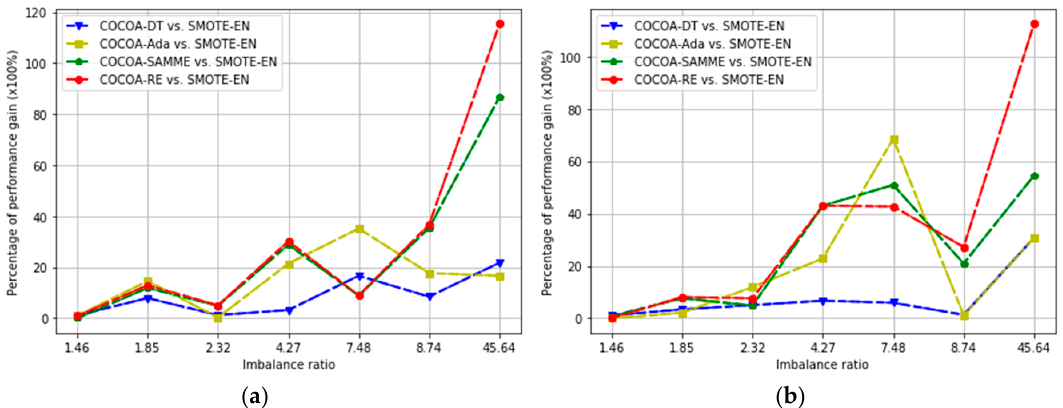
Figure 2. Percentage of performance gain between each algorithm based Cross-Coupling Aggregation (COCOA) and SMOTE-EN ( PG q ) changes along imbalance ratio of the class label q : ( a ) the changes of performance gains based on F-measure when the binary classifier is decision tree; ( b ) the changes of performance gains based on F-measure when the binary classifier is neural network. SMOTE-EN: an ensemble version of synthetic minority over-sampling technique.